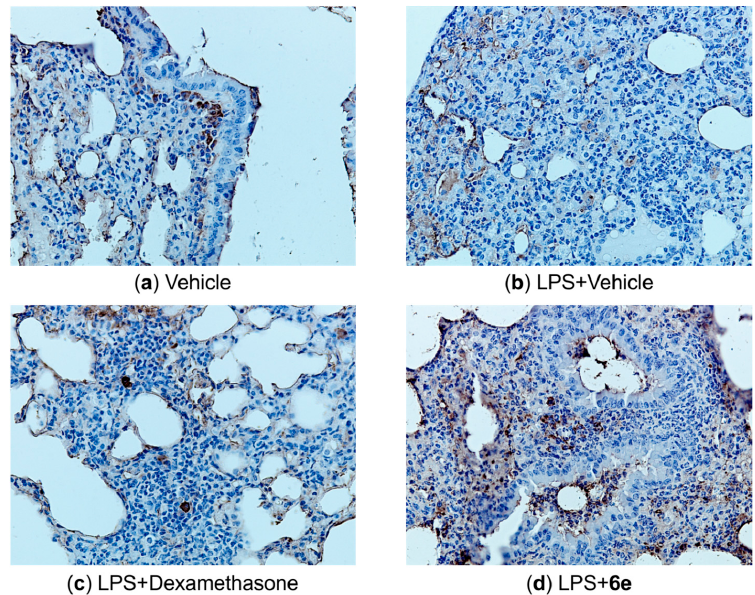
Figure 6. Lung sections. H&E staining, magnification ×400. ( a ) Intact control; ( b ) LPS-control; ( c ) LPS + 5 mg/kg dexamethasone; ( d ) LPS + 30 mg/kg 6e . At the same time, it should be noted that, in all experimental animals of this group, despite the dense infiltration of immune cells into the lung tissue (Figure 7), alveolar septa damage was significantly less pronounced than in mice of the LPS control group, as shown in Table 2.